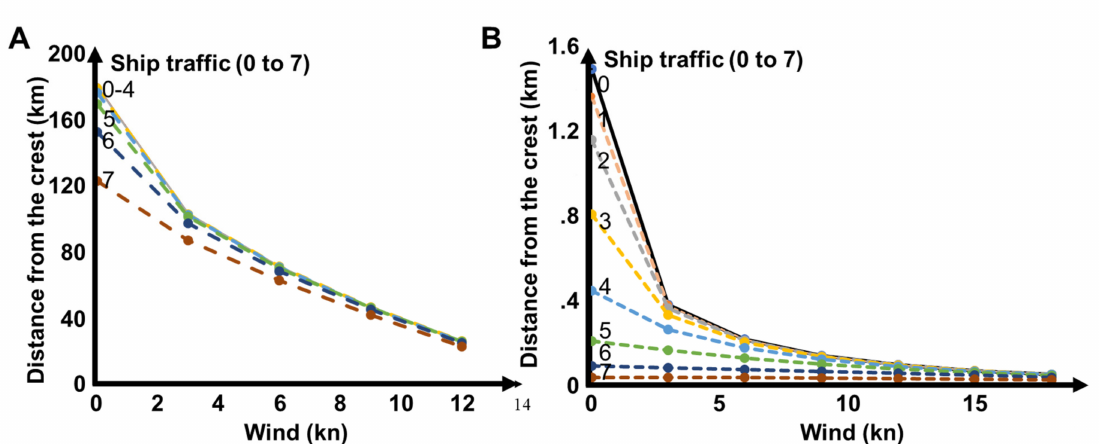
Figure 6. Detection distance of ( A ) the individual sounds represented as the 90th percentile with 10 dB above the Wenz background noise (Q 0.90 − 10) between 570 and 2000 Hz ( B ) and fish ambient noise level (ANL) as a function of the wind in knots. The solid line is without considering boats and dashed lines are when considering ship traffic from the Wenz model; each colour corresponds to a ship traffic regime also numbered from 1 (upper line) to 7 (bottom